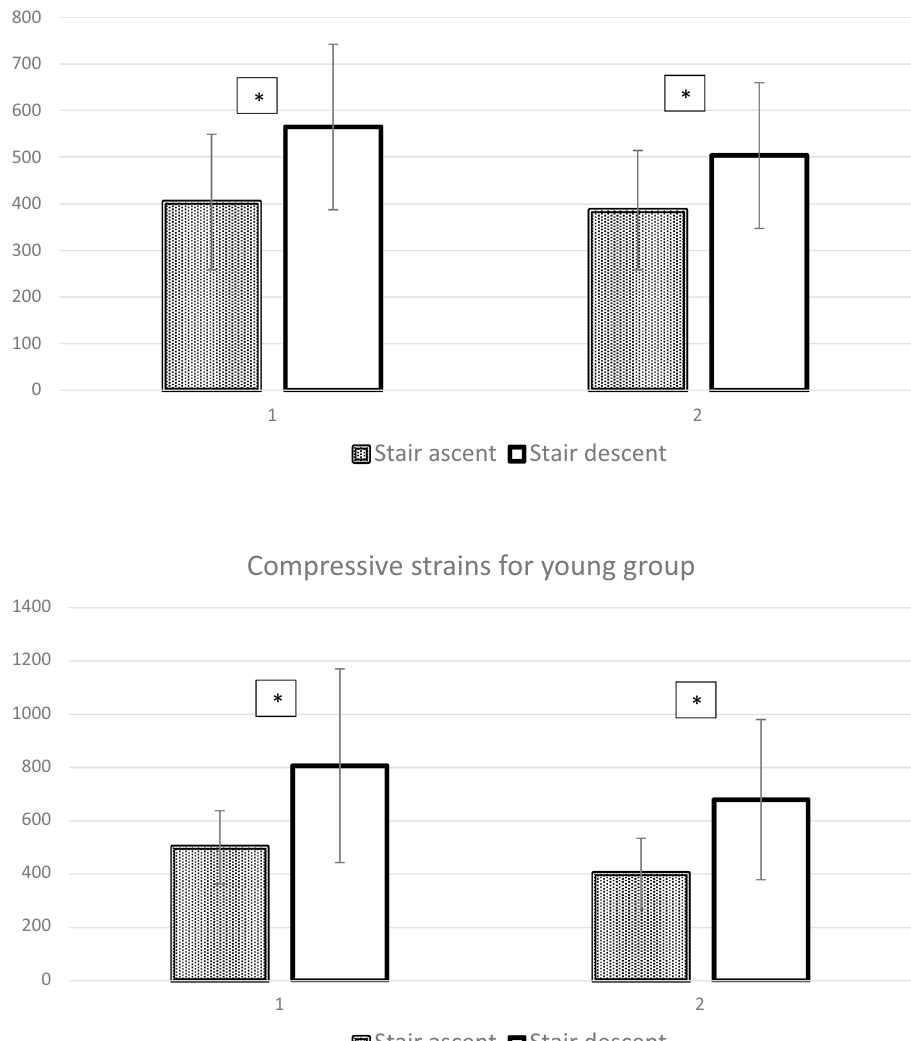
Figure 1. The averaged peak compressive strains (unit: µε) for older and young groups (Means ± SD). In Horizontal axis, 1 indicated peak 1, 2 indicated peak 2. *Stands for the significant difference comparing to stair descent ( P <